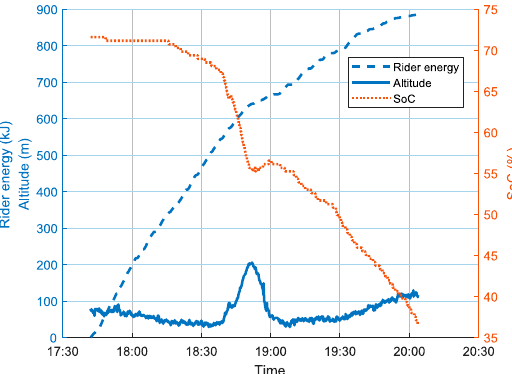
Figure 16. Battery charging process.